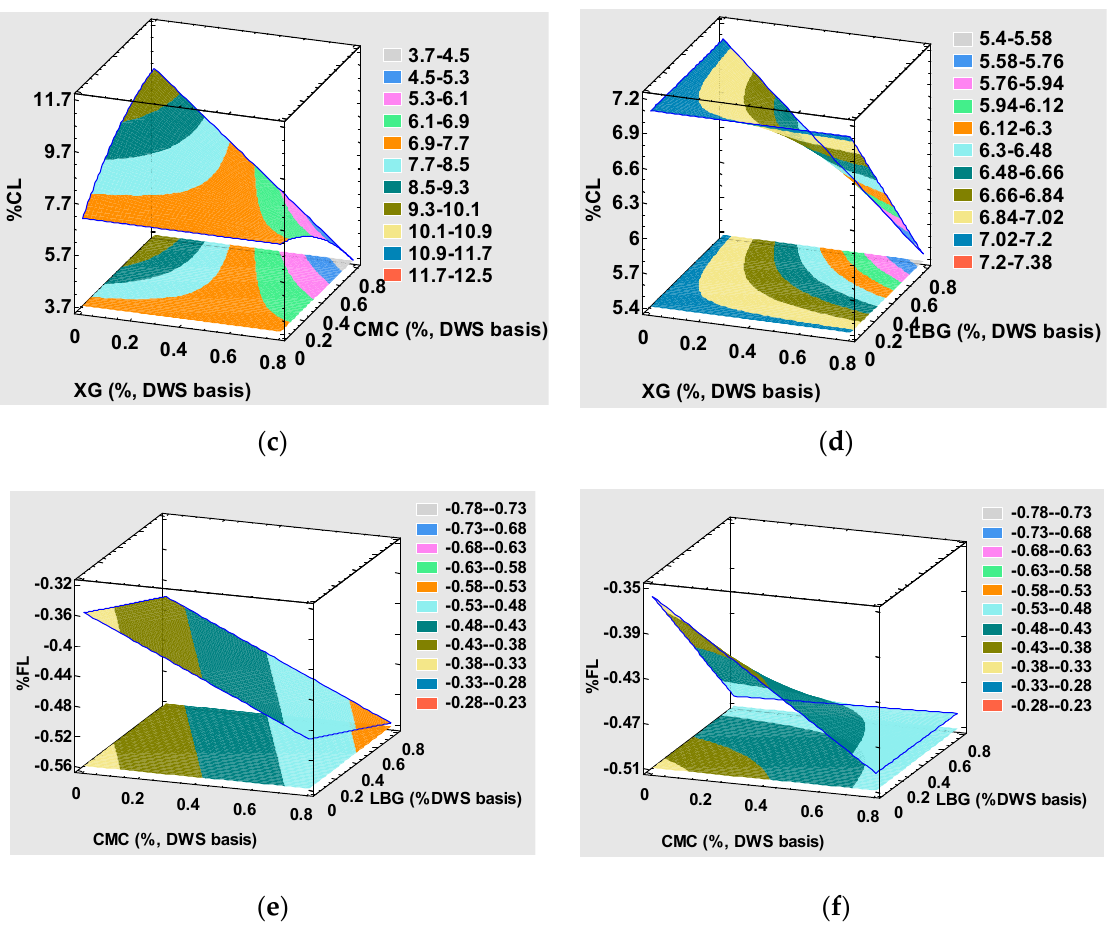
Figure 2. ( a – f ). Effect of the CMC, GX, and LBG levels on water absorption index (WAI), the swelling index (%SI), cooking loss (%CL), and fiber loss (%FL). CMC, carboximethylcelullose; XG, xanthan gum; LBG, locust bean gum.